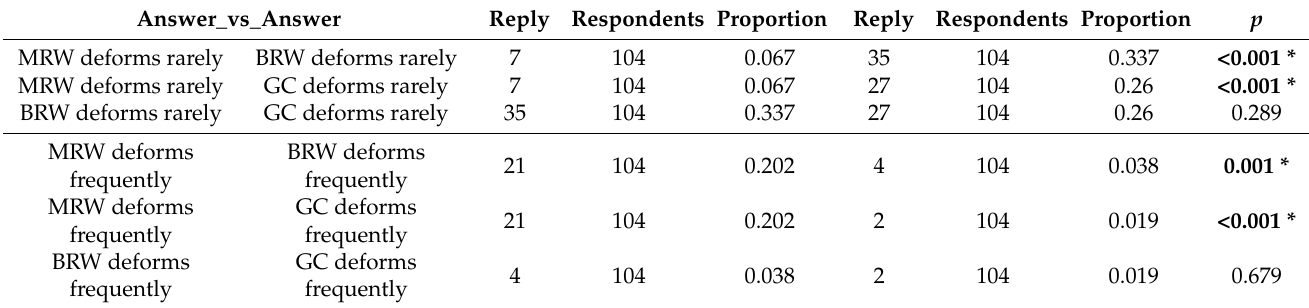
Table 6. Susceptibility to deformation according to the